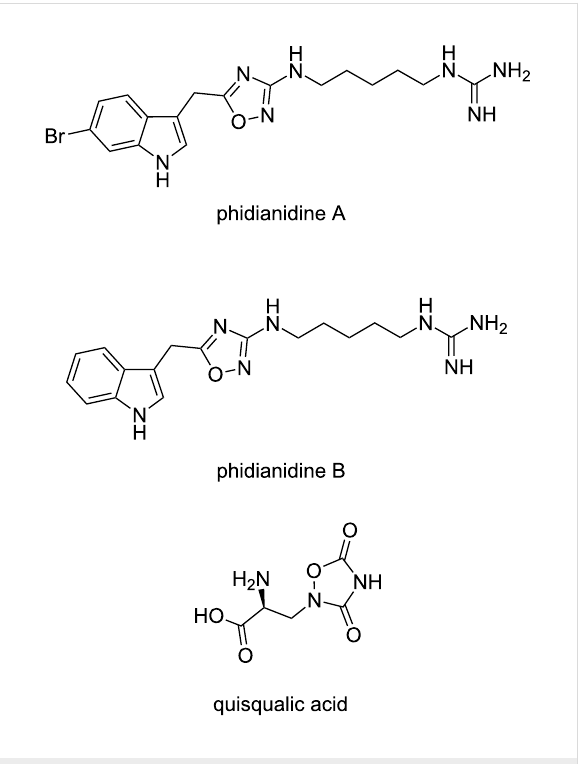
Figure 1: Natural products having a 1,2,4-oxadiazole